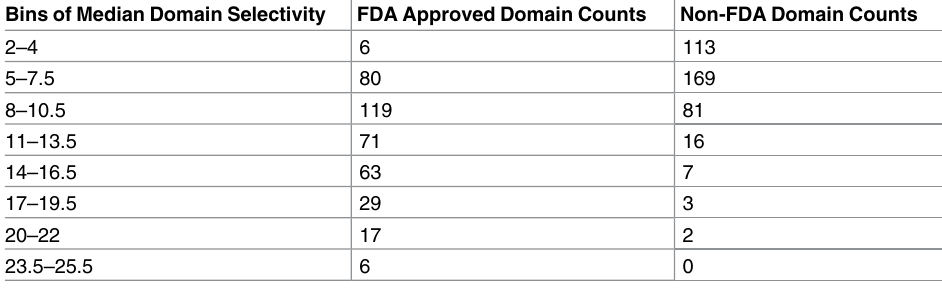
Table 3. Frequency of pfam domains binned by median domain selectivity of active compounds. Each row represents a set of Pfam domainswhose active compounds (against targets with that domain) have a mediandomain selectivity in the range specified.Domainselectivity is the same as introducedin the “Target Selectivity Distribution” section above, where active targets sharing a common domainare countedonly once. The ranges are orderedfrom top to bottom by increasingnumberof distinct domain active targets. We report bin counts separately for FDA Approvedand Non-FDA